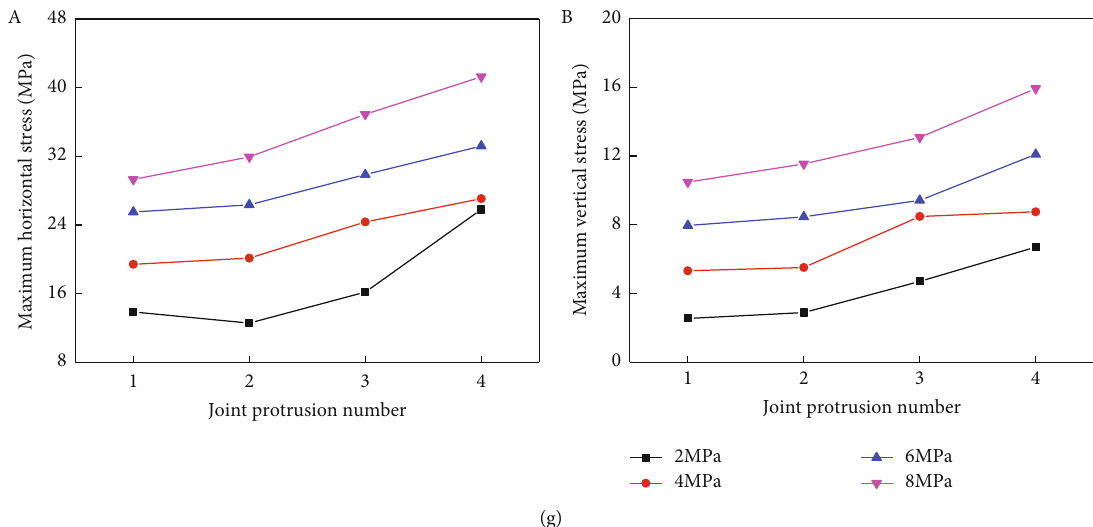
Figure 17: Maximum stress distribution of joint protrusions under di ff erent normal stresses: (a) joint 1; (b) joint 2; (c) joint 3; (d) joint 4; (e) joint 5; (f) joint 6; (g) joint